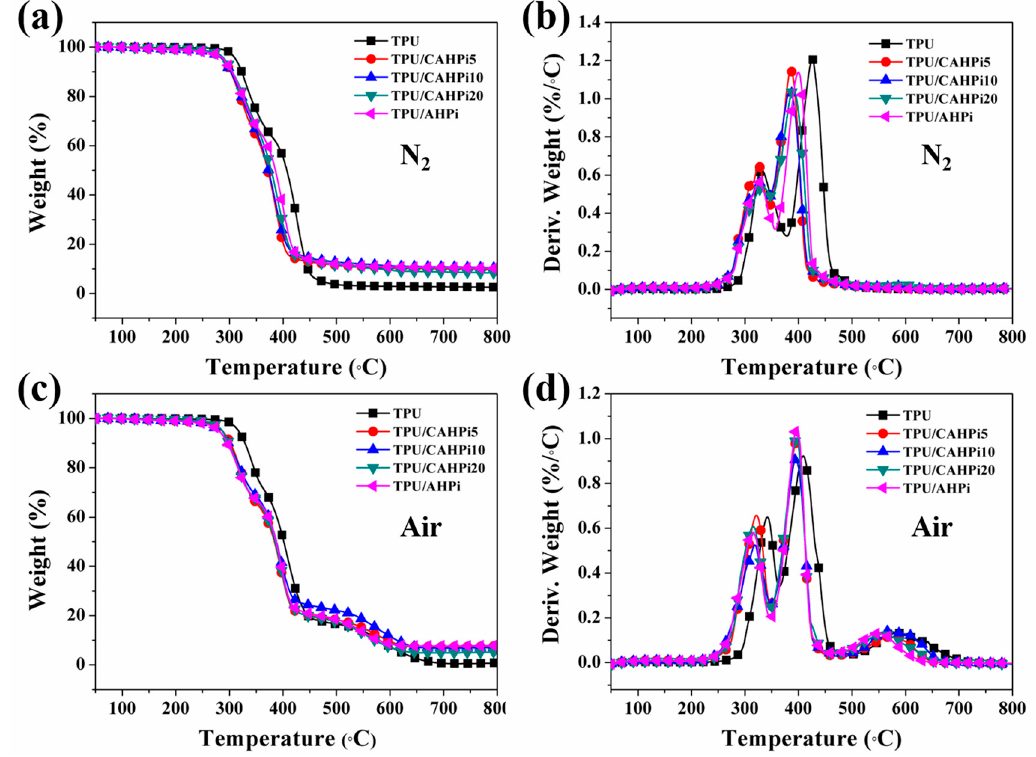
Figure 3. ( a , c ) Thermogravimetric analysis (TGA) and ( b , d ) derivative thermogravimetry (DTG) curves of thermoplastic polyurethane (TPU) and its nanocomposites in N 2 and air atmospheres. Table 1. TGA data of TPU and its nanocomposites in N 2 and air atmospheres. Sample No.